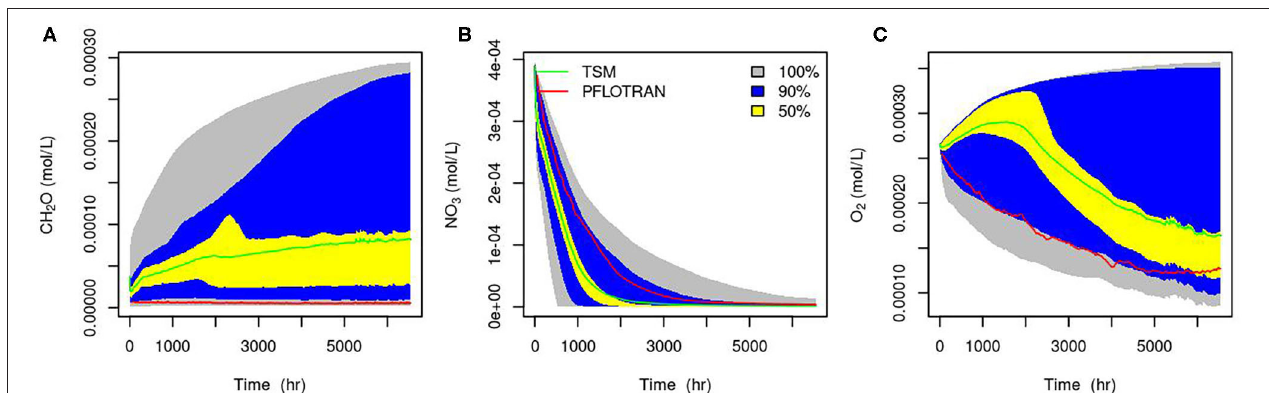
FIGURE 9 | 50, 90, 100% percentiles of 1,600 TSM simulations for the concentrations of CH 2 O (A) , NO 3 − (B) , and O 2 (C) , red line is from PFLOTRAN, and green line is the mean of the TSM models at each hour. Parameter sensitivity were analyzed based on the average of the temporal concentrations of CH 2 O, NO 3 , and O 2 and the sensitivity indices are shown in Figure 8 . Reaction rate constants k NO 3 and k O 2 are the most important for concentrations of